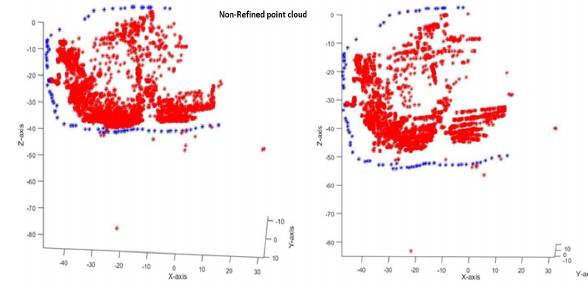
Figure 6. SURF based Multi-view matched keypoints